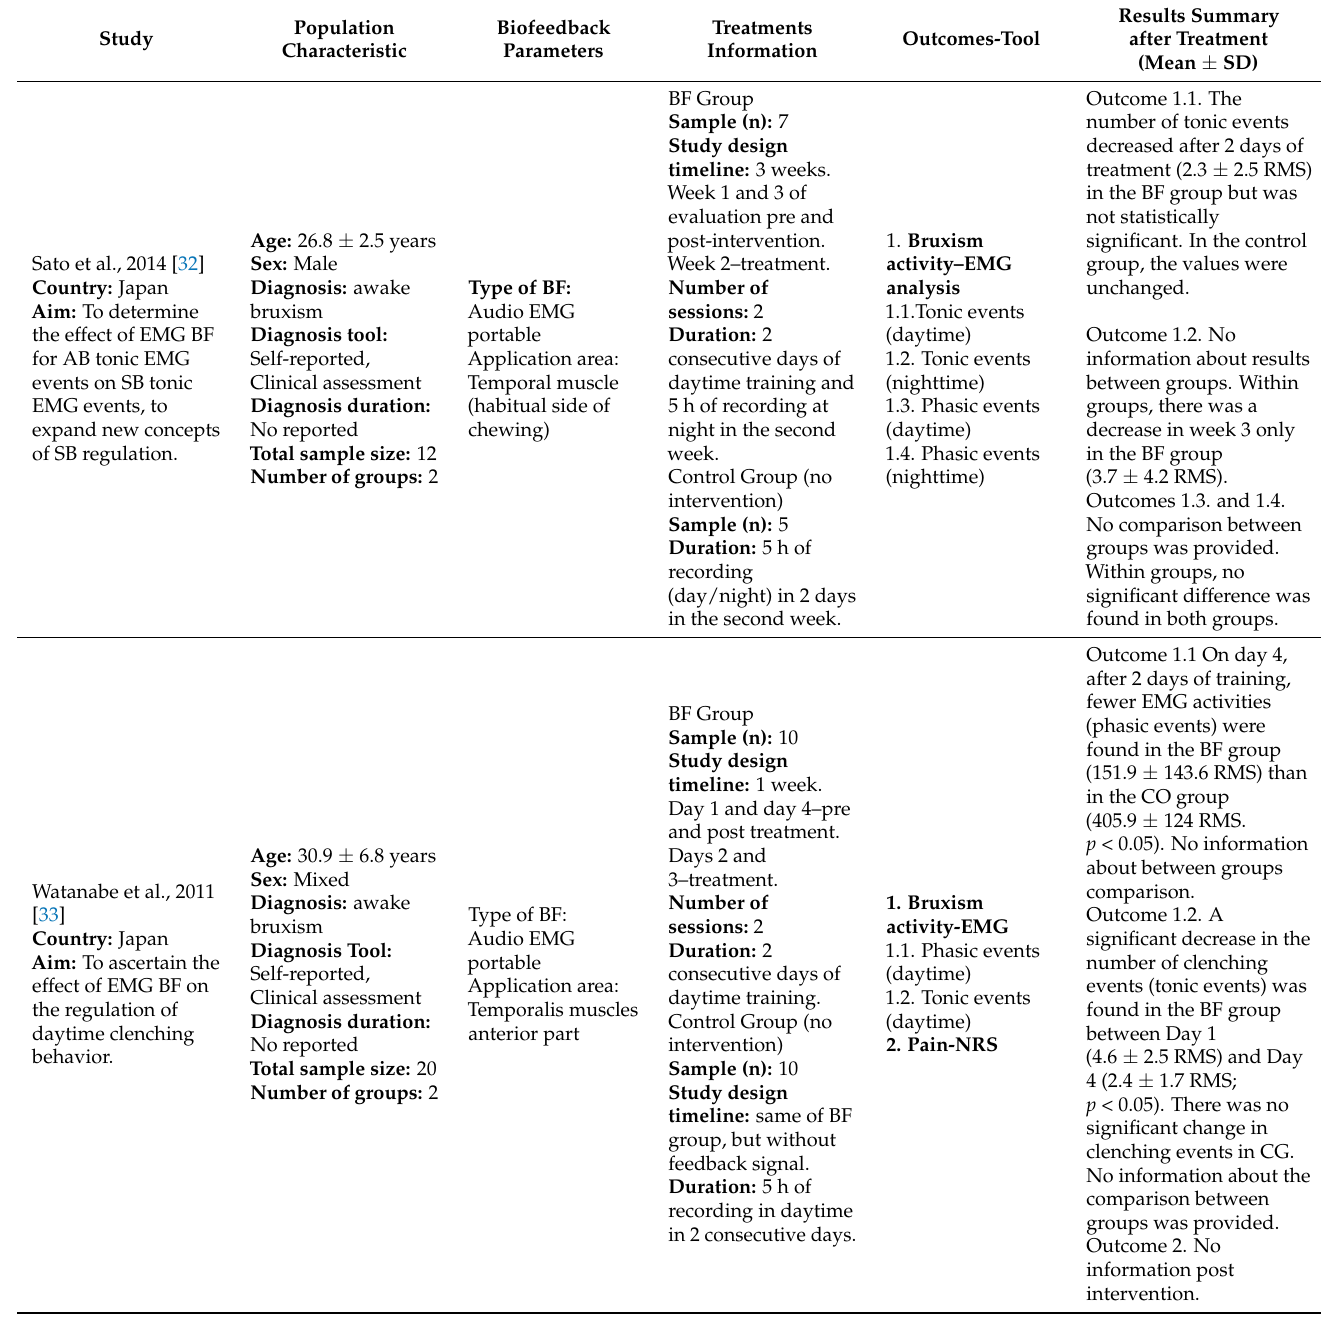
Table 1. Summary of the studies’